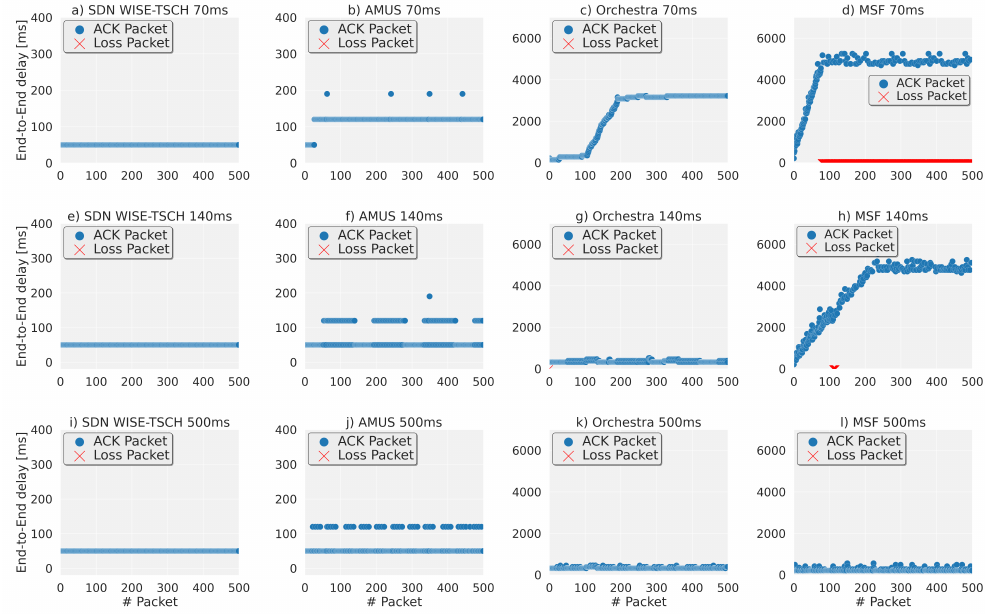
Figure 4. End-to-End Delay for different transmission